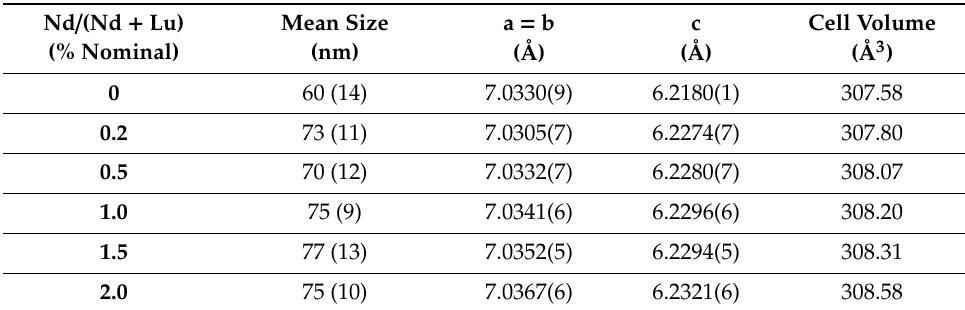
Table 1. Mean size, unit cell parameters, cell volume, and crystallite size of the particles obtained by aging at 120 °C for 20 h. EG/H 2 O solutions containing Lu(NO 3 ) 3 , Nd(NO 3 ) 3 , (Nd(NO 3 ) 3 + Lu(NO 3 ) 3 = 0.04 mol dm − 3 , and variable Nd/(Nd + Lu mol ratio) and sodium orthovanadate (0.04 mol dm − 3 ) in EG/H 2 O medium (ratio by volume = 3.5/1.5). Standard deviations for particle size and unit cell parameters errors are included in parentheses.